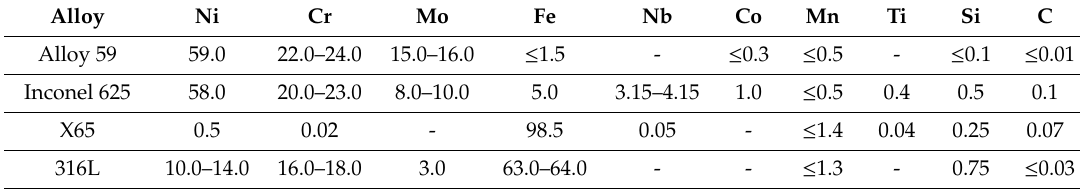
Table 1. Comparison of nominal chemical composition (wt %) of di ff erent